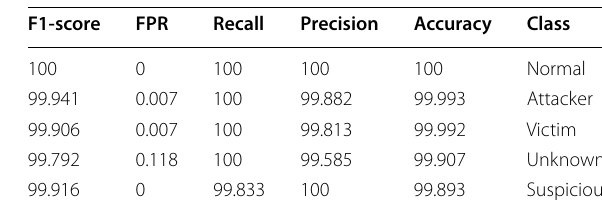
Table 2 Performance of the proposed model after using multi- class classification architecture in terms of F1-score, FRP, Recall, Precision, and Accuracy